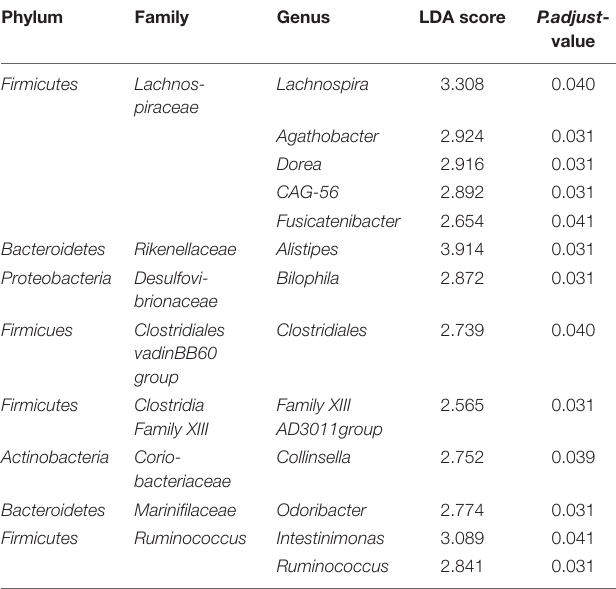
TABLE 2 | Linear effect size score (LEfSe) that predicts which genera are responsible for the differential bacterial composition after the UVB light exposure of the VDS −